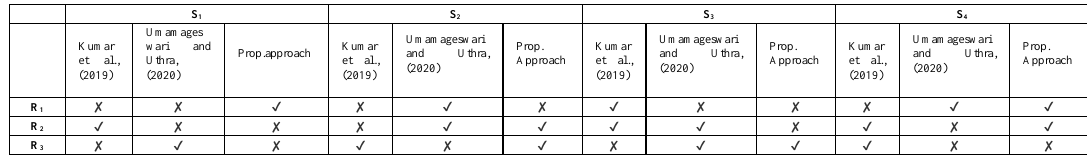
Table 7. Table of comparison for allocation for example 1.